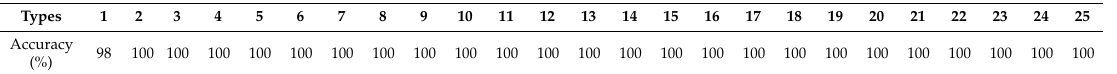
Table 10. Confusion matrix for twenty-five hand postures using our dataset.